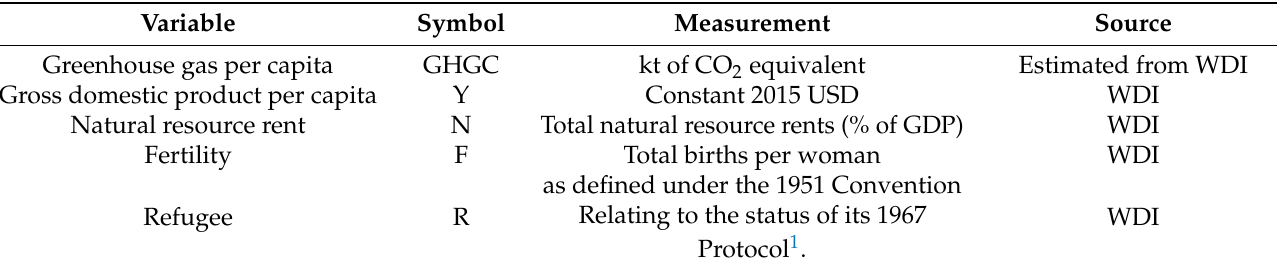
Table 3. Details of the variables.